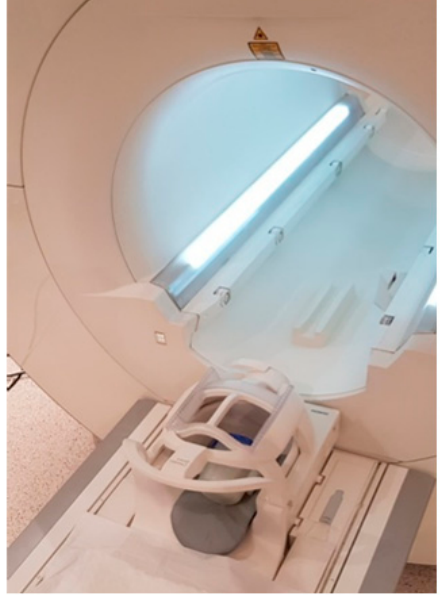
Figure 13. NMR scanning set up with a head coil used for placement of samples. Since the CT and TPS systems were linked together, the alignment of the samples for CT scanning was realized, creating virtual reference points and using an LAP laser system for the adjustment of the different coordinates. Physical markers were used for adjusting the MRI scanning coordinates for the